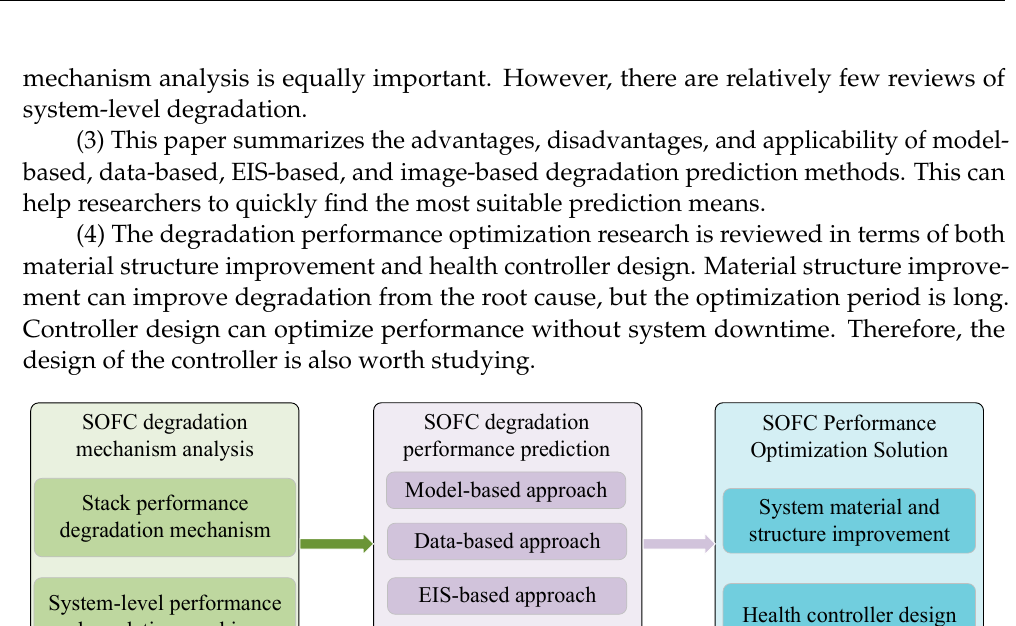
Figure 1. Solid oxide fuel cell (SOFC) performance degradation study process.